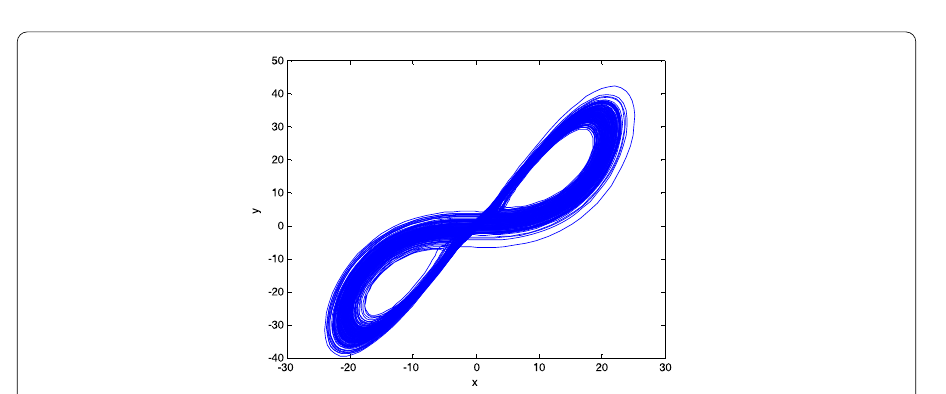
Figure 3 Chaotic attractors of system (2) in xOy